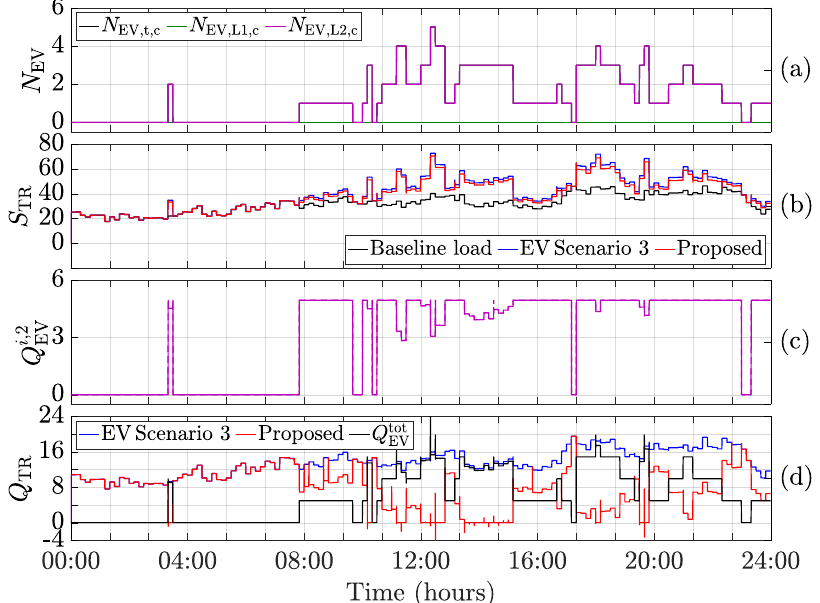
Figure 12. Scenario 3: EV charging at Level 2, ( a ) number of EVs present; ( b ) transformer apparent power in kVA; ( c ) Q supplied by an online EV at Level 2 in kVAr; ( d ) transformer reactive power in kVAr.